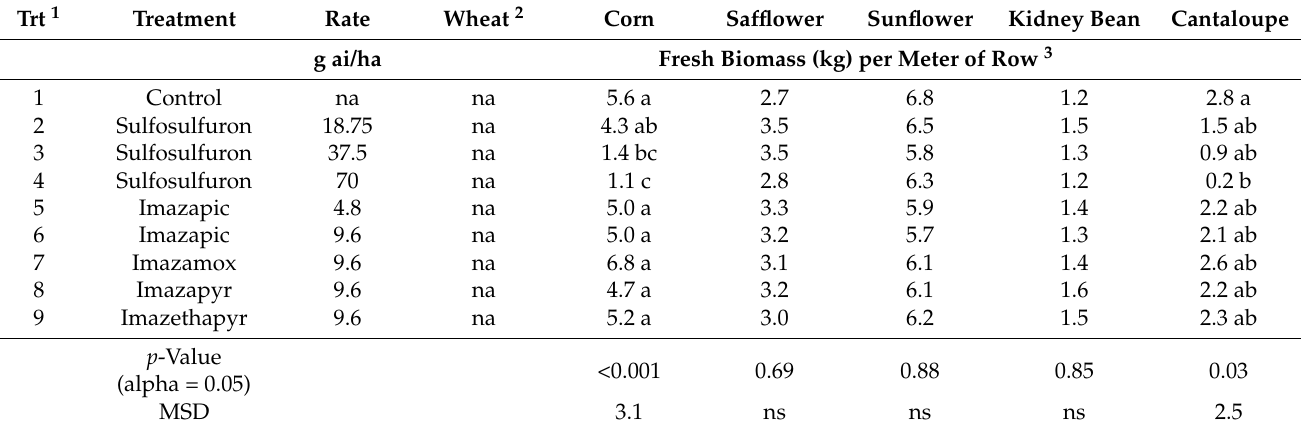
Table 4. Rotational crop above-ground fresh biomass in 2020 following 2019 herbicide treatments in processing tomato for management of branched broomrape in